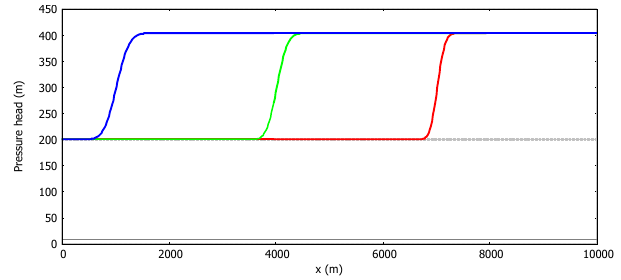
Figure 12. Pressurized transient in a pipe junction. Pressured head vs time x = 500 m (red), x = 1000 m (green) and x = 5000 m (blue).